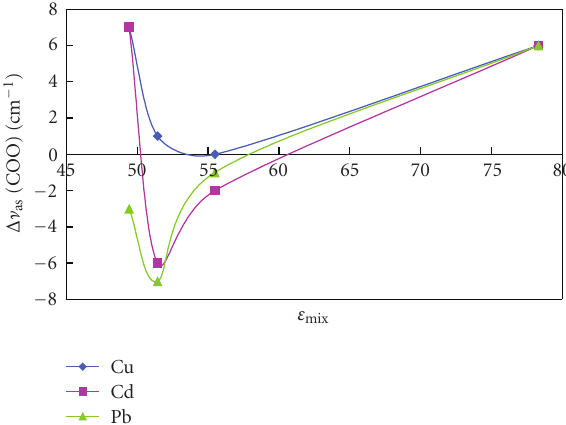
was not a ff ected. The shift in ν as COO ( Δ ν as COO) varied upon metal binding and changing solvent, and a wider range of this shift was observed with decrease in dielectric constant values (Figure 4), where Δ ν as COO = ( ν as COO free solvent − ν as COO metal-loaded